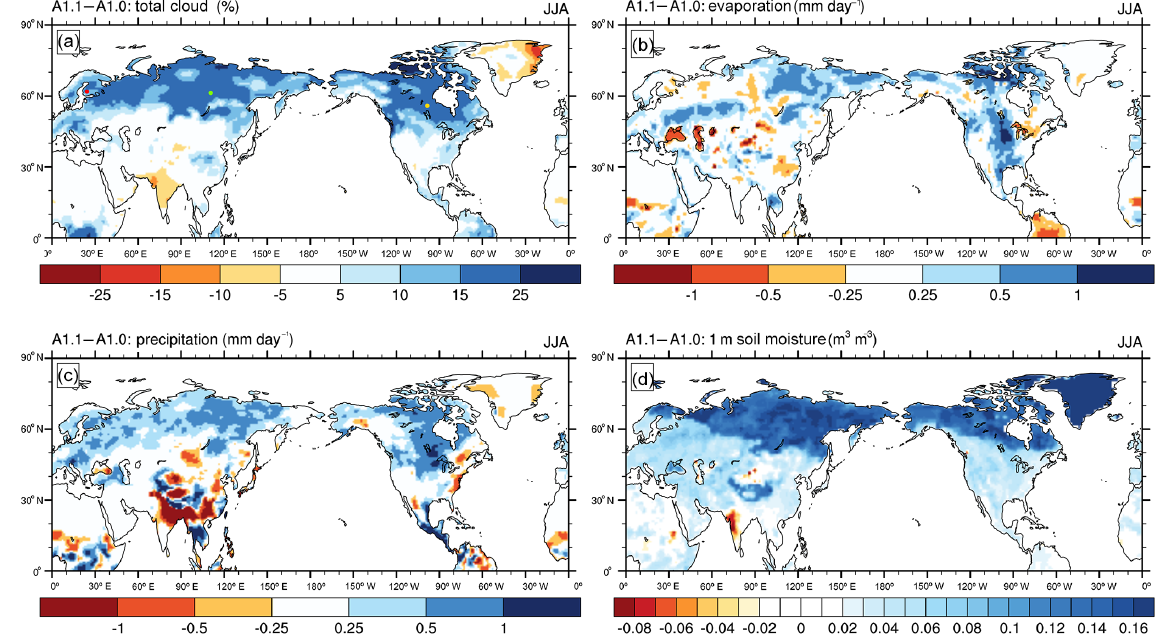
Figure 8. Seasonal mean difference in (a) total cloud fraction, (b) evaporation (mmday − 1 ), (c) precipitation (mmday − 1 ), and (d) 1m soil moisture (m 3 m − 3 ) between ACCESS1.1 and ACCESS1.0 for JJA. Boreas (Canada), East Siberia (Russia), and Hyytiälä (Finland) marked as yellow, green, and red dots respectively in panel (a) .